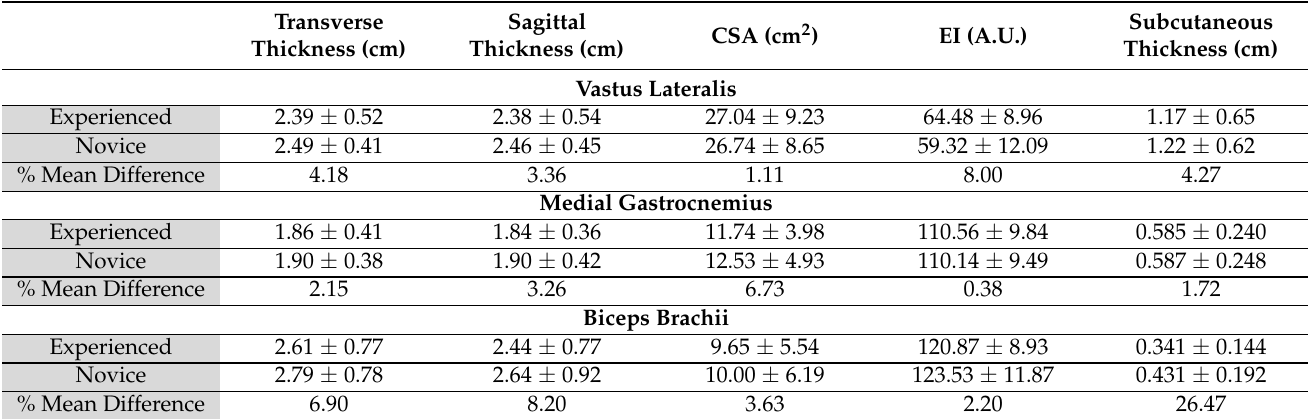
Table 1. Mean ± SD values and the % mean difference between the experienced and novice sonographers for each muscle and variable.